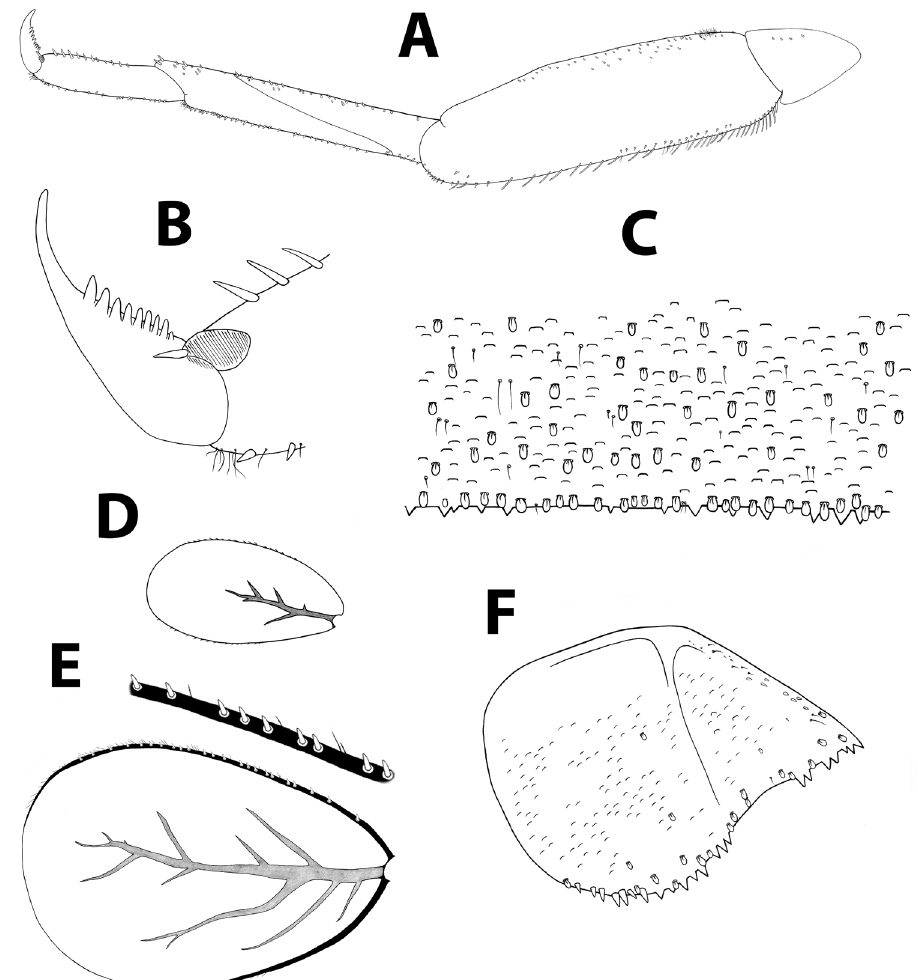
Figure 13. Baetis noa sp. n., nymph. A foreleg B tarsal claw C abdominal tergum V, surface and distal margin D gill I E gill IV, costal margin, detail F paraproct plate. hen; 2N (on slides), Senir Stream (nature reserve), 05.xi.2015, Z. Yanai & S. Cohen; 6N, Dan Stream (Tel Dan), 31.v.2016, Y. Hershkovitz; 68N, Dan Stream (Dan), 31.v.2016, Y. Hershkovitz; 24N (1N on slide), Senir Stream (nature reserve), 09.iii.2017, Z. Yanai & J.-L. Gattolliat; 80N, Dan Stream (Tel Dan), 10.iii.2017, Z. Yanai & J.-L. Gattolliat; 2N, Dan Stream (Dan), 07.v.2017, Z. Yanai; 13N, Yehudiyya Stream, 12.iv.2018, Z. Yanai; 36N, Dan Stream (Dafna), 13.iv.2018, Z. Yanai. Other material . ISRAEL: 8N (1N on slide), Hermon Stream (Panyas Springs), 19.ii.2014, Z. Yanai; 16N (1N on slide), May- mon Spring, 22.vi.2014, Z. Yanai; 18N, Senir Stream (nature reserve), 15.vii.2014, Z. Yanai; 3N, Senir Stream (Bet Hillel), 05.xi.2015, Z. Yanai & S. Cohen; 54N, Maymon Spring, 04.iv.2016, Z. Yanai; 10N, Dan Stream (Dafna), 31.v.2016, Y.